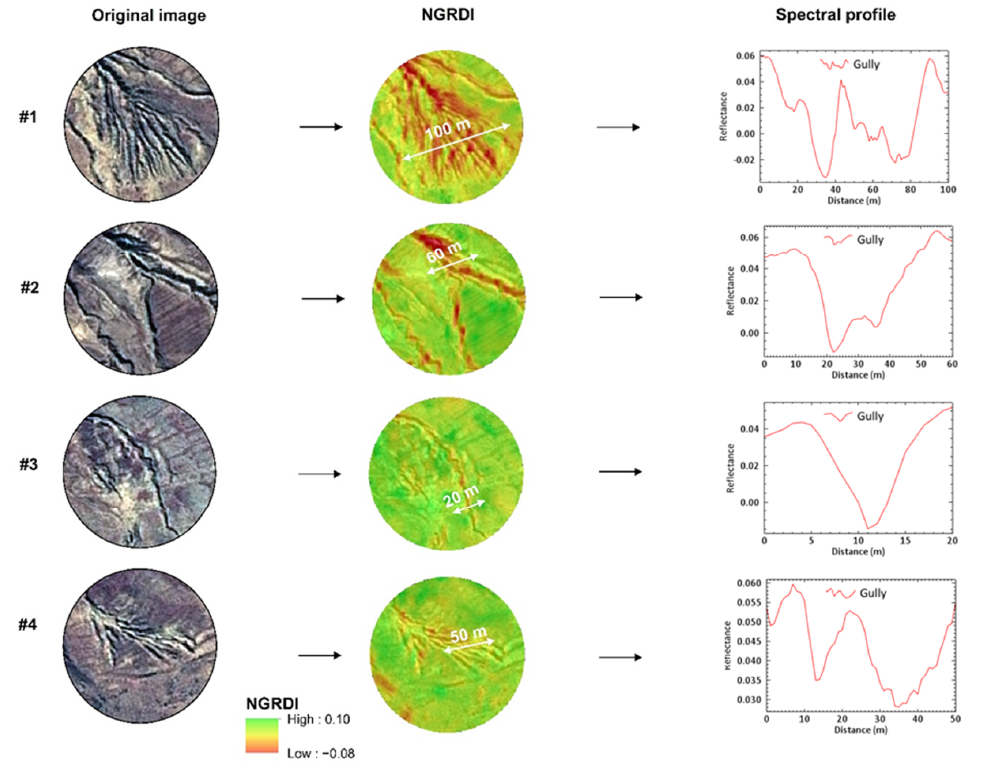
Figure 6. Gully transects (20–100 m) with Normalized Green Red Difference Index (NGRDI)-based spectral profiles of selected gullies.